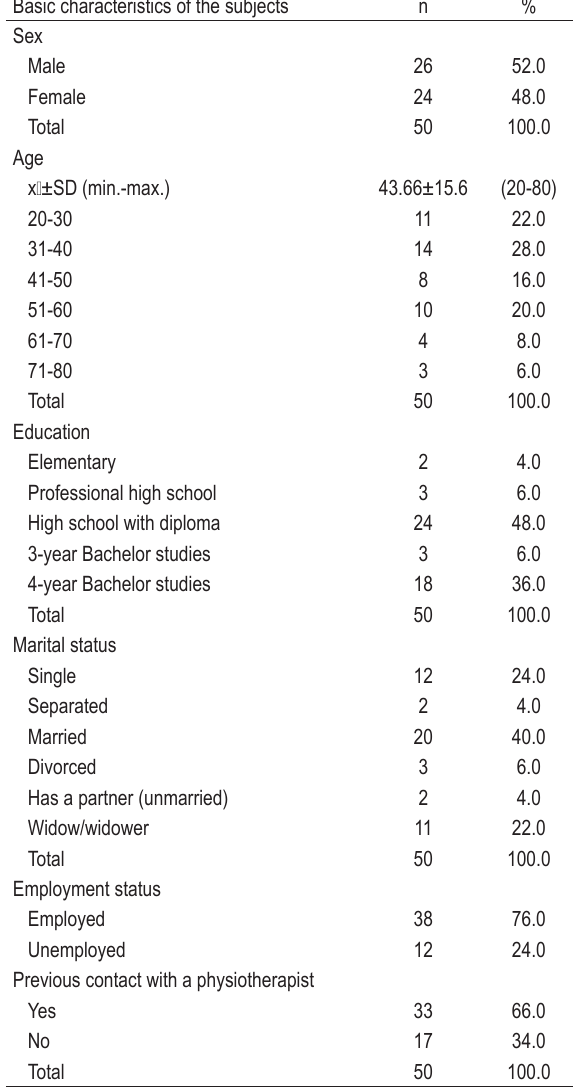
TABLE 3. Overview of mean scores – subscale II - Health policy and TABLE 1. Basic characteristics of the subjects